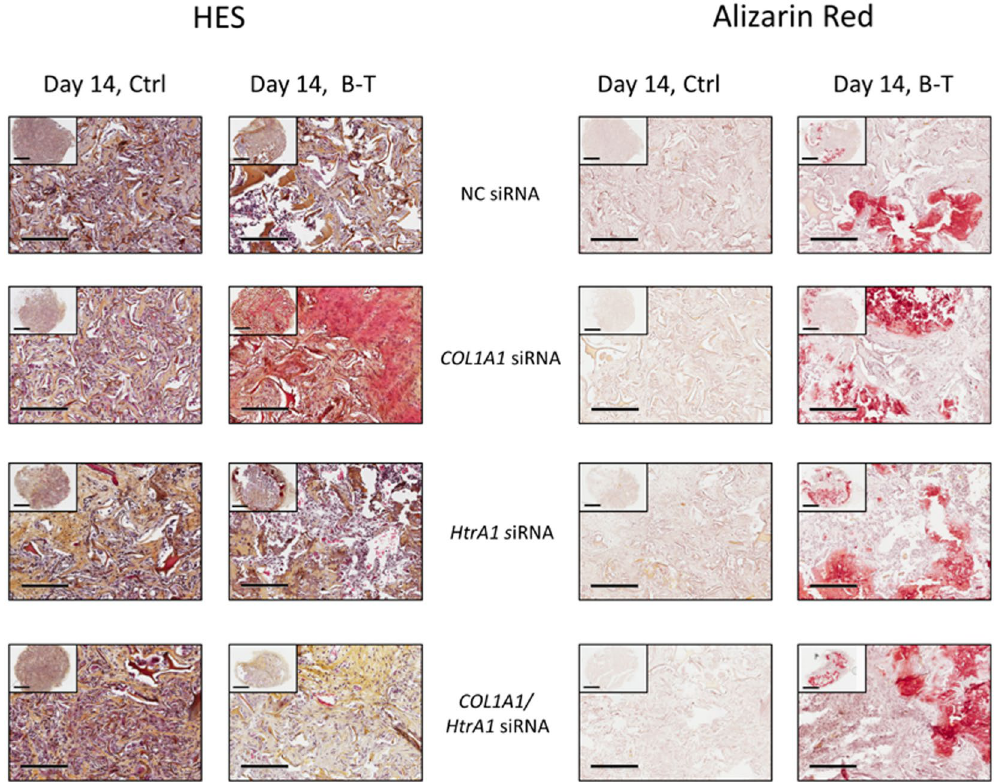
Figure 8. Histological evaluation of ectopic transplants. hBM-MSCs were cultured under hypoxia, with or without BMP-2/TGF- β 1 (B-T), and transfected with NC, COL1A1 , and/or HtrA1 siRNAs in type I collagen sponges for 14 days, as described in Fig. 6. They were then implanted subcutaneously in nude mice and monitored for 28 days, as described in Materials and Methods. HES and alizarin red stainings of the constructs were then performed. Images shown are representative of the experimental results obtained from two of three independent experiments. Scale bars: 1 mm and 200 µ